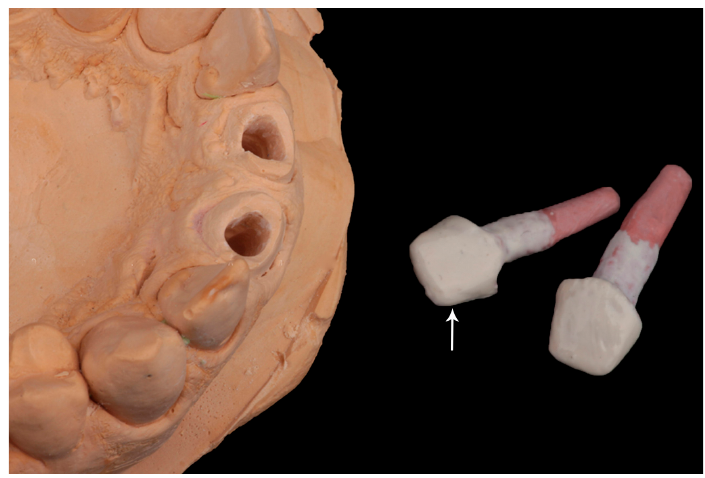
Figure 5. Custom ‐ made PEEK post and core. (The arrow refers to opaque white layer to hide the reddish color of PEEK).